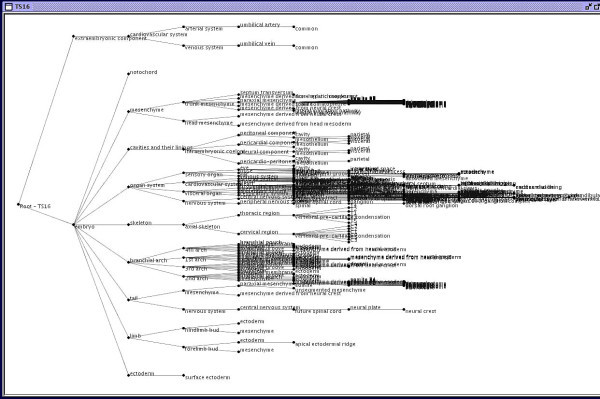
Weighted distribution of nodes in L-R layout for TS16. Compared to the unweighted distribution for the same DAG in Figure 8 this layout makes better use of space, aiding analysis in areas in areas of high density by reducing occlusion.